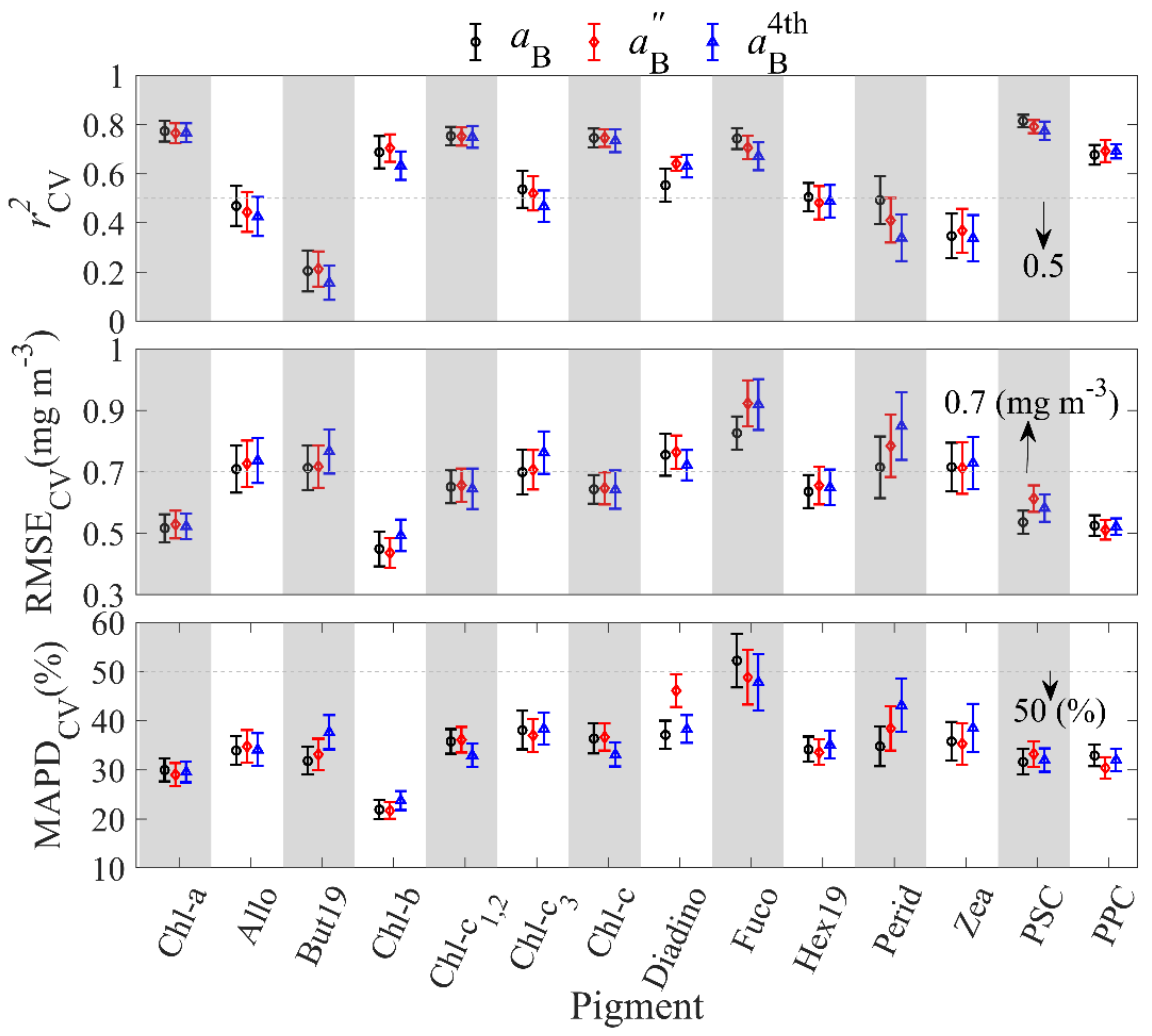
Figure 7. Cross-validation (CV) statistics ( r 2 CV , RMSE CV , MAPD CV ) between observed pigment concentrations and modeled pigment concentrations produced by the PLS model. Results for a B ( λ ) (black), 𝑎 (cid:2886)(cid:4593)(cid:4593) (𝜆) (red), and 𝑎 (cid:2886)(cid:2872)(cid:2930)(cid:2918) (𝜆) (blue) are compared.